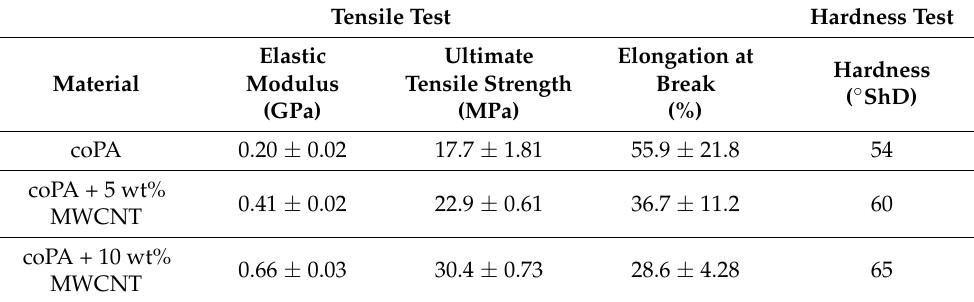
Table 3. Mechanical properties of neat coPA and coPA/MWCNTs composites.